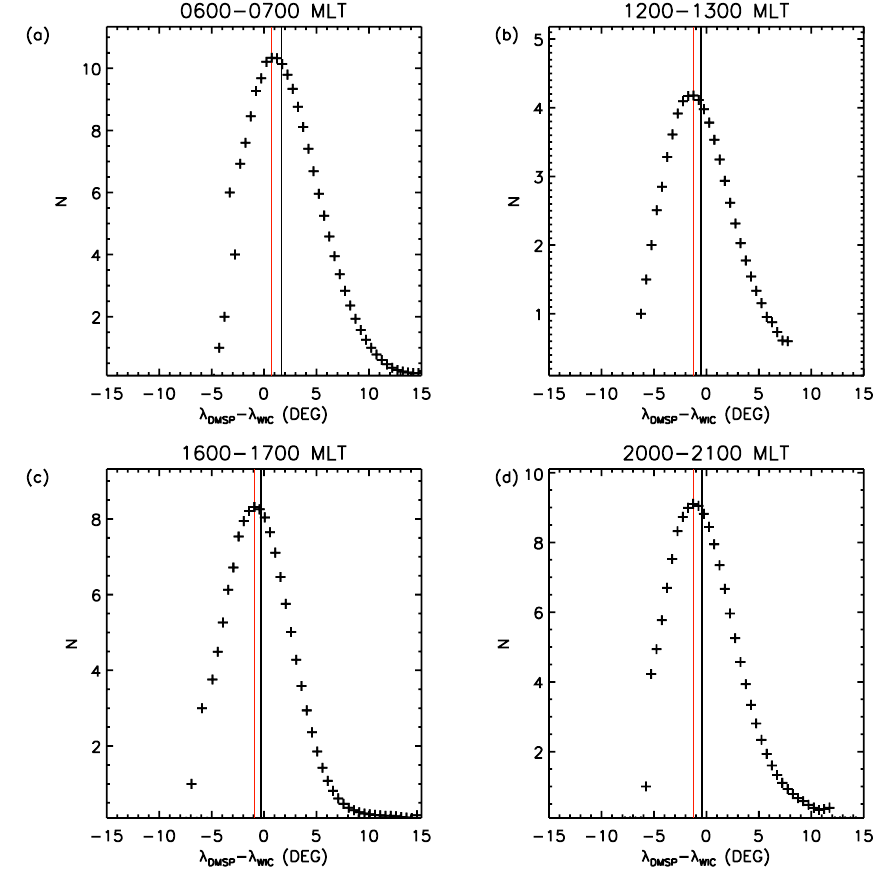
Fig. 4. Smoothed frequency distributions for λ DMSP − λ WIC for (a) 06:00–07:00MLT, (b) 12:00–13:00MLT, (c) 16:00–17:00MLT and (d) 20:00–21:00MLT in bins of 0.5 ◦ magnetic latitude. Vertical black lines show the mean of the distributions and red lines represent the